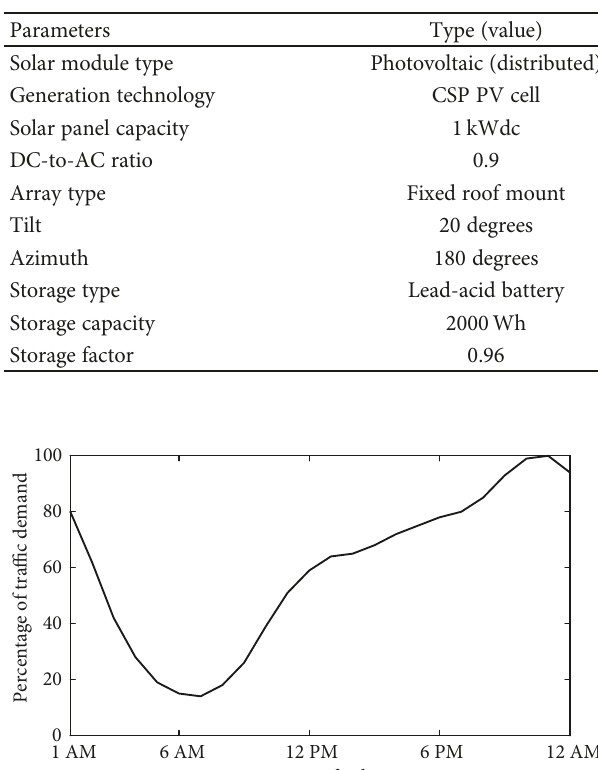
Table 1: Solar panel and storage device parameters.